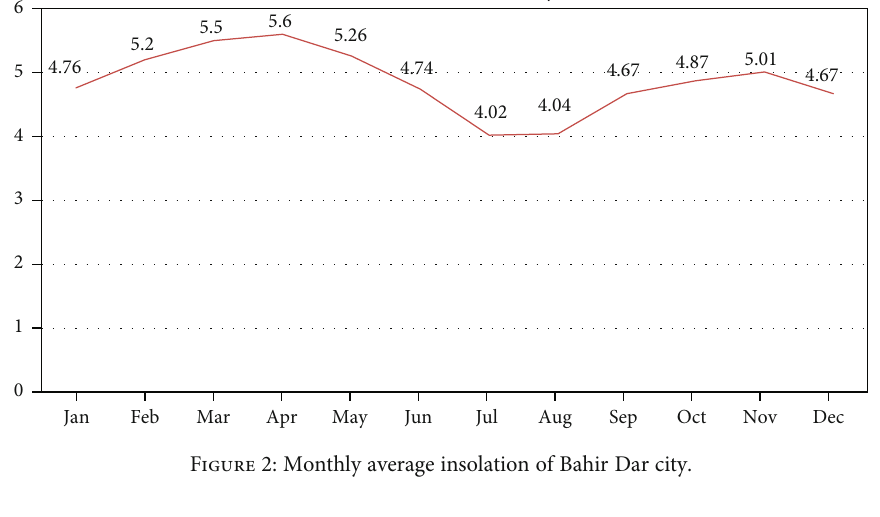
Figure 2: Monthly average insolation of Bahir Dar city.